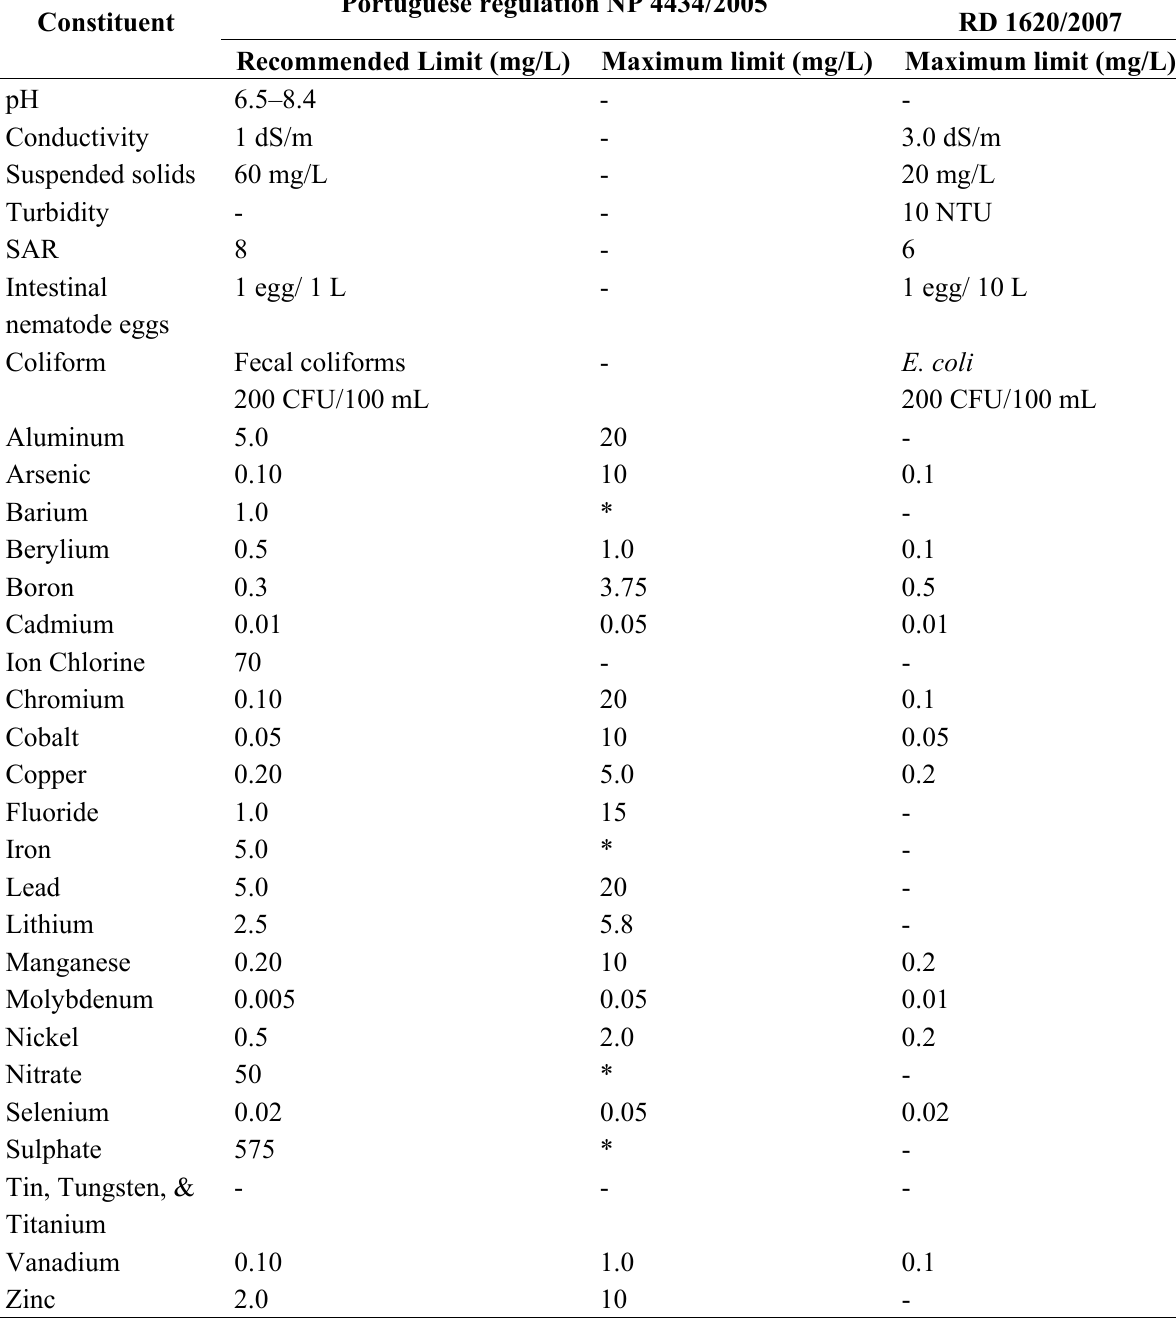
Table 10. Reclaimed water quality regulations for golf course irrigation in Portugal and Spain